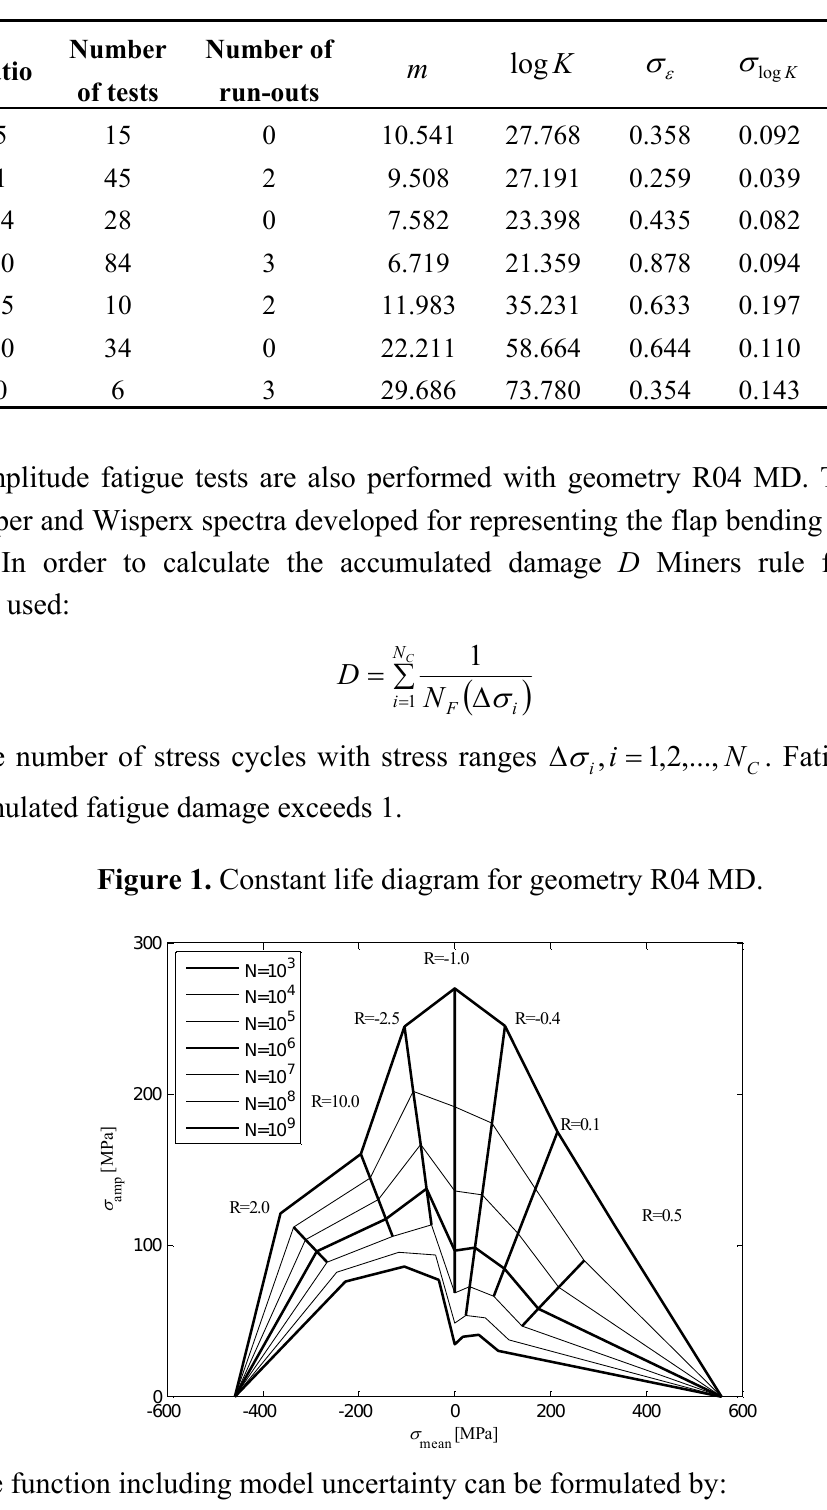
Table 2. SN-curves for different R-ratios for geometry R04 MD.